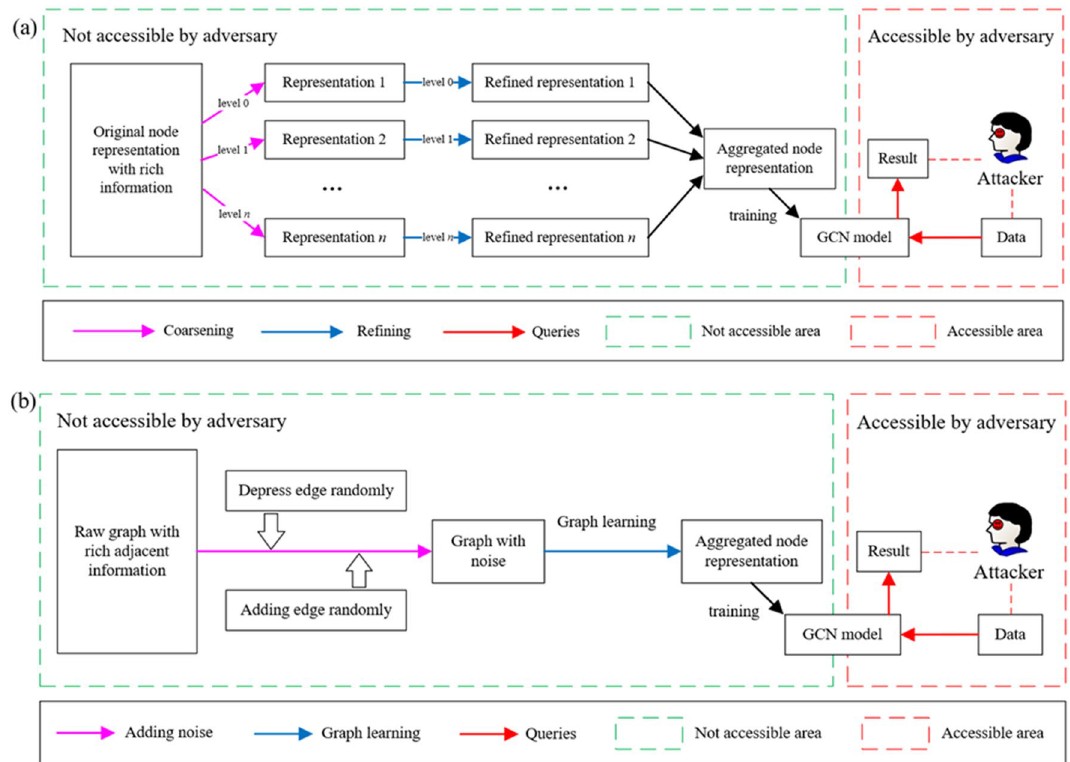
Figure 7. Overall of preserving approach: ( a ) node representation, ( b ) adjacent